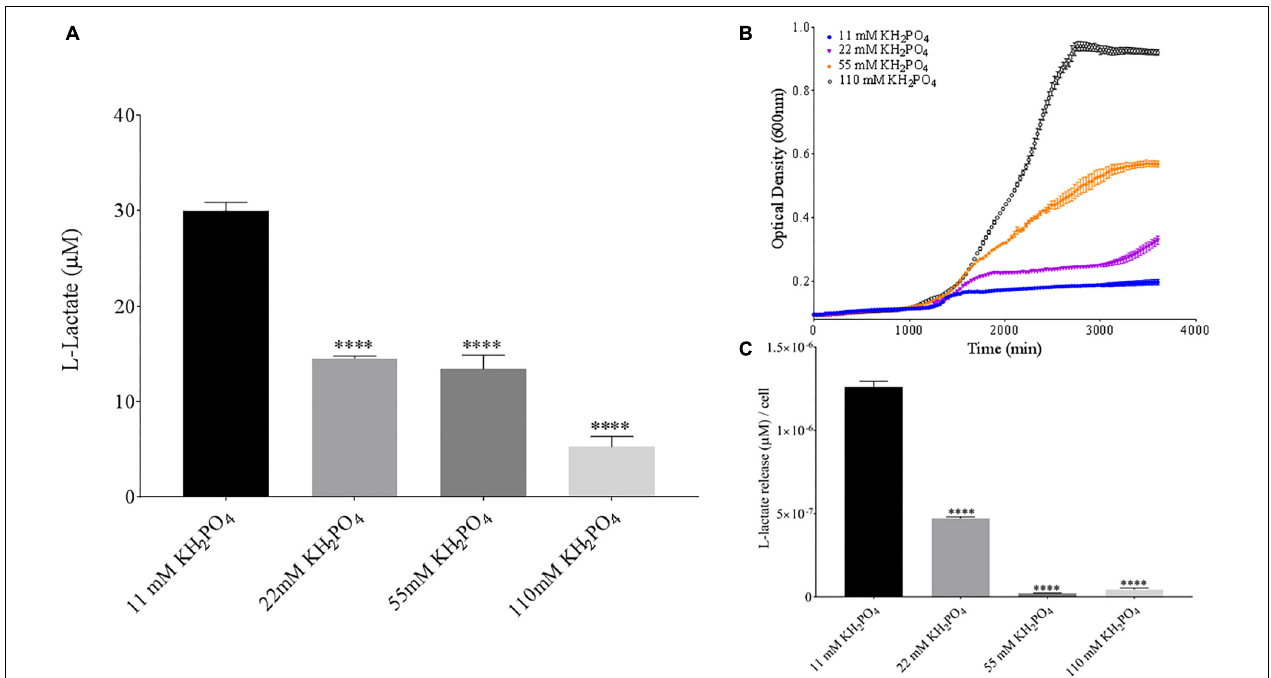
FIGURE 9 | Bacillus pumilus B12 decreases L-lactate released from PLA in increased KH 2 PO4. (A) Initial measurements of B. pumilus B12 L-lactate release from PLA taken after 48 h. KH 2 PO4 concentration increases are based off standard MSM with glucose (MSM + G). These assays were performed with three biological and three technical replicates. (B) Optical density-based growth curves of B. pumilus B12 in the phosphate sources taken over 50 h. Each growth curve represents eight biological replicates. (C) Normalized L-lactate release/cell based on data from (A,B) . ∗∗∗∗ indicates ANOVA p -value ≤ 0.0001 compared to MSM +